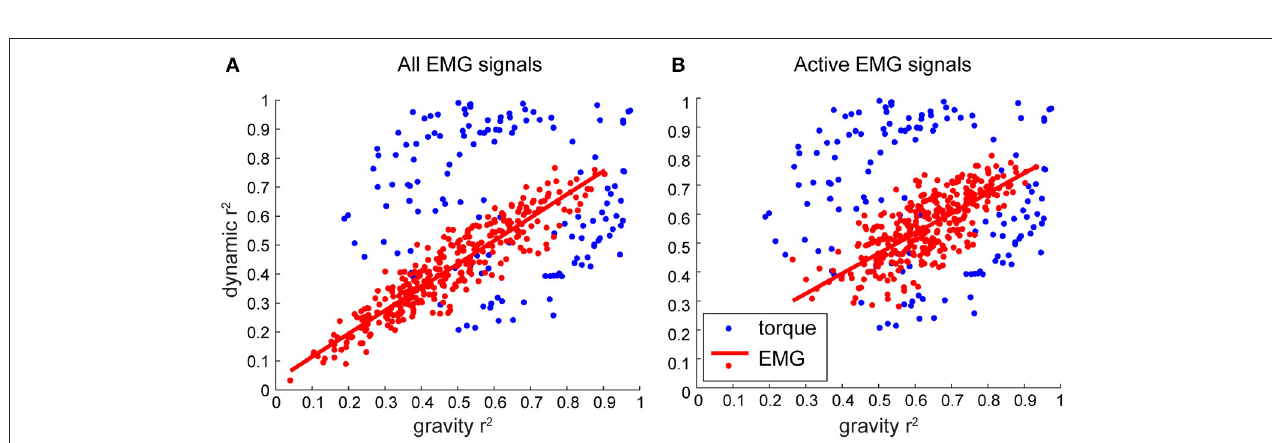
FIGURE 6 | The relative contribution of individual components to EMG and muscle torques per subject. Each plot shows data for a single subject. Each dot represents a value per signal (muscle or DOF) per movement.